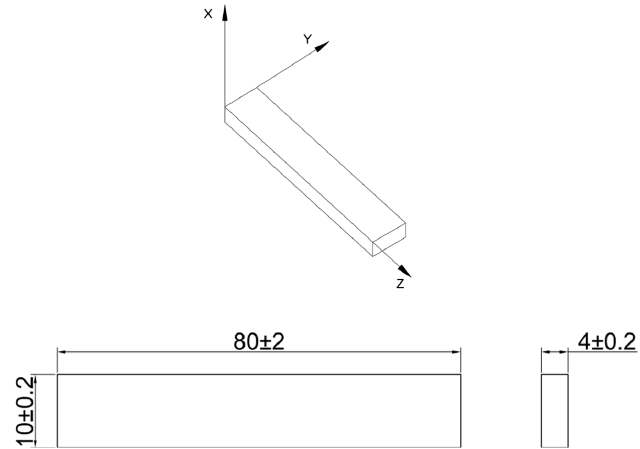
Figure 1. Axes of the test samples and geometric dimensions.